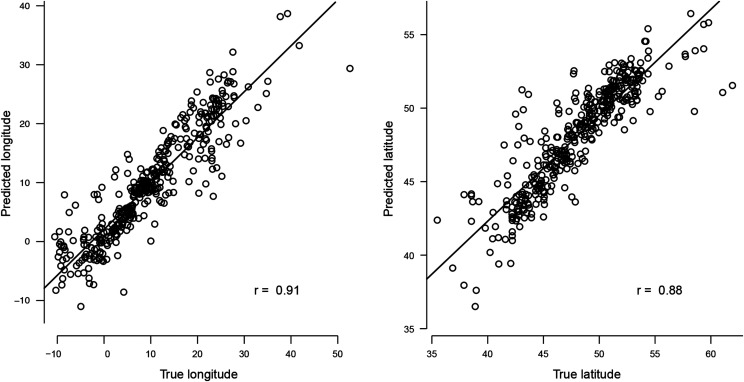
Scatterplot of predicted and true (a) longitude and (b) latitude (WGS84, DD) of sites of origin of perennial ryegrass populations. Leave one out cross validation was used to evaluate the genomic prediction models. All available SNP markers were used. Prediction abilities are assessed by r (lowest right corner).